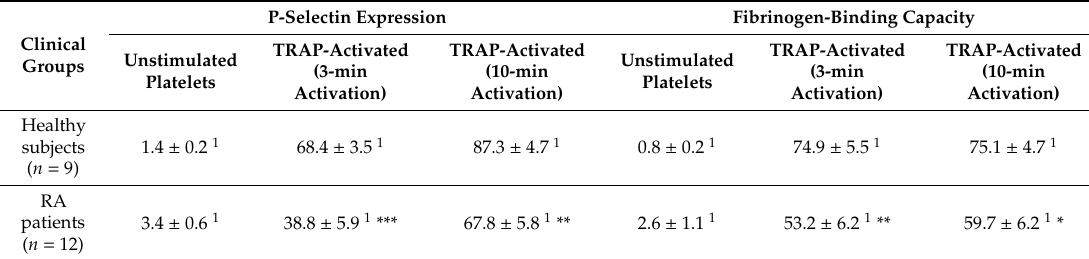
Table 1. Characterization 1 of platelets isolated from the blood of RA patients and control healthy subjects before and after stimulation with the thrombin receptor-activating peptide